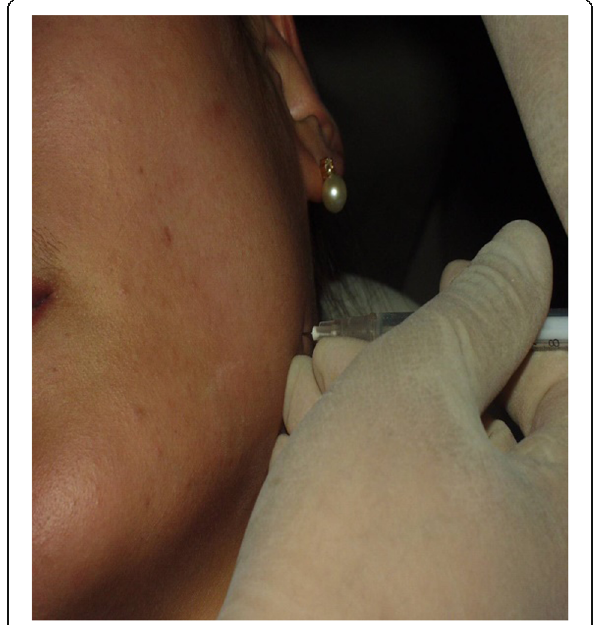
Fig. 6. In the case of a square jaw patient, inject the toxin 1.5 – 2 cm far away from the margin of the mandible. Inject the toxin into the center of the triangle formed with a line joining corner of the mouth and tragus of the ear with a line joining the angle of the mandible and corner of the mouth